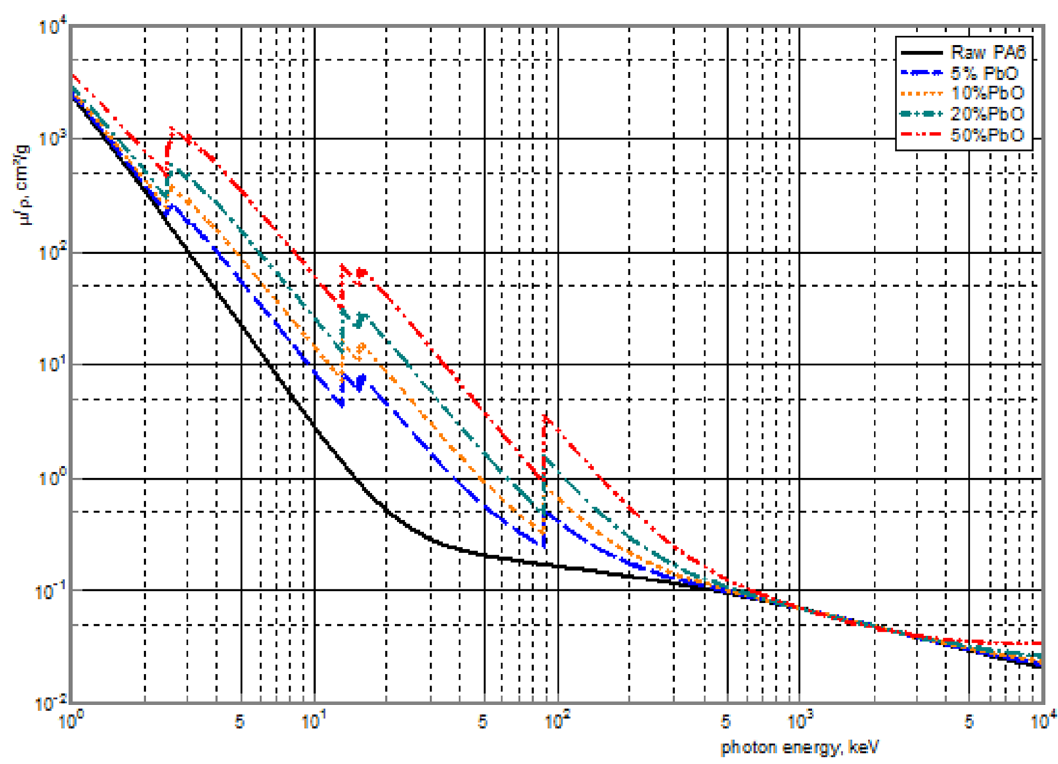
Figure 7. The trend of changes in the mass attenuation coefficients in a broad energy range for the five studied